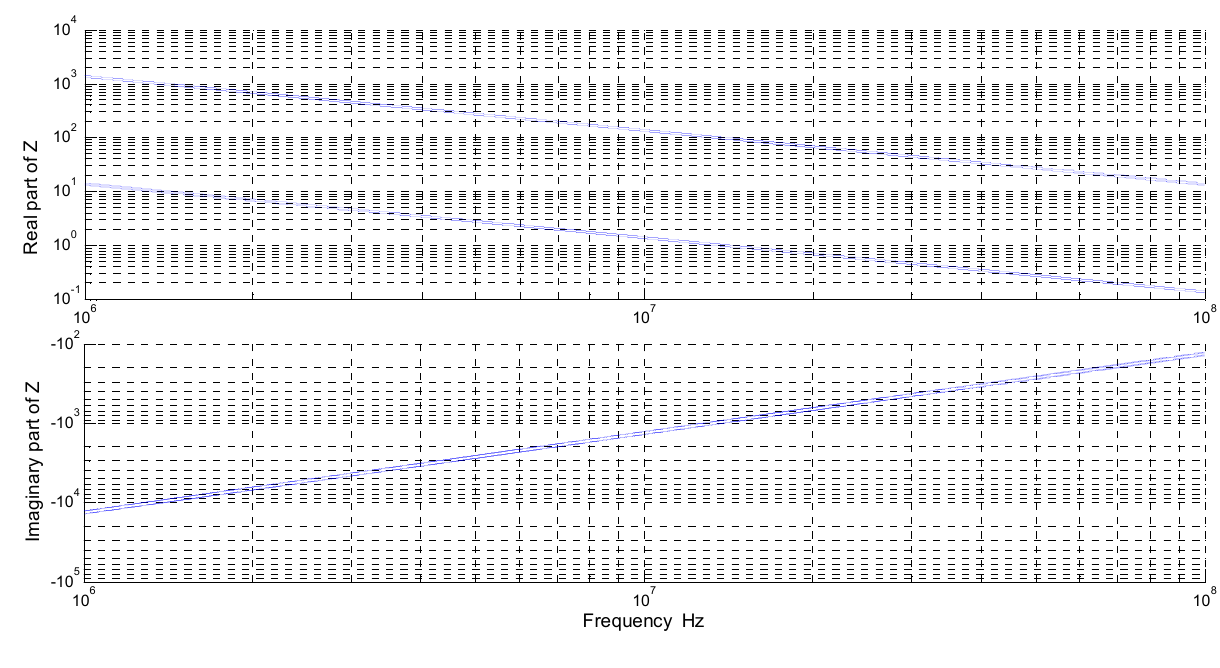
Figure 5. Operational range of impedance for the sensor (cylindrical